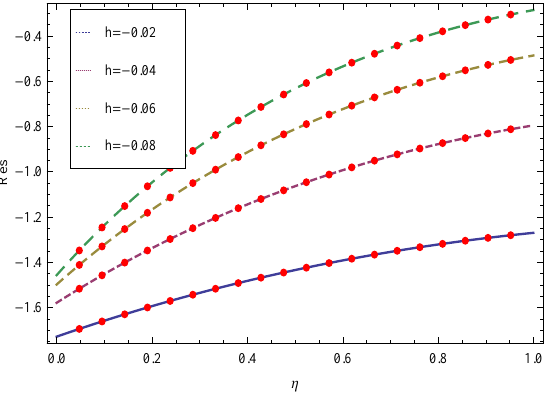
Figure 28. Elaborates h curves of φ (cid:48) ( 0 ) , when λ = 0.2, S = 0.2,kr = 0.2,Pr = 1,Ec = 0.6,Nb = 0.4, Nt = 0.5, β = 1, Sc = 0.5.